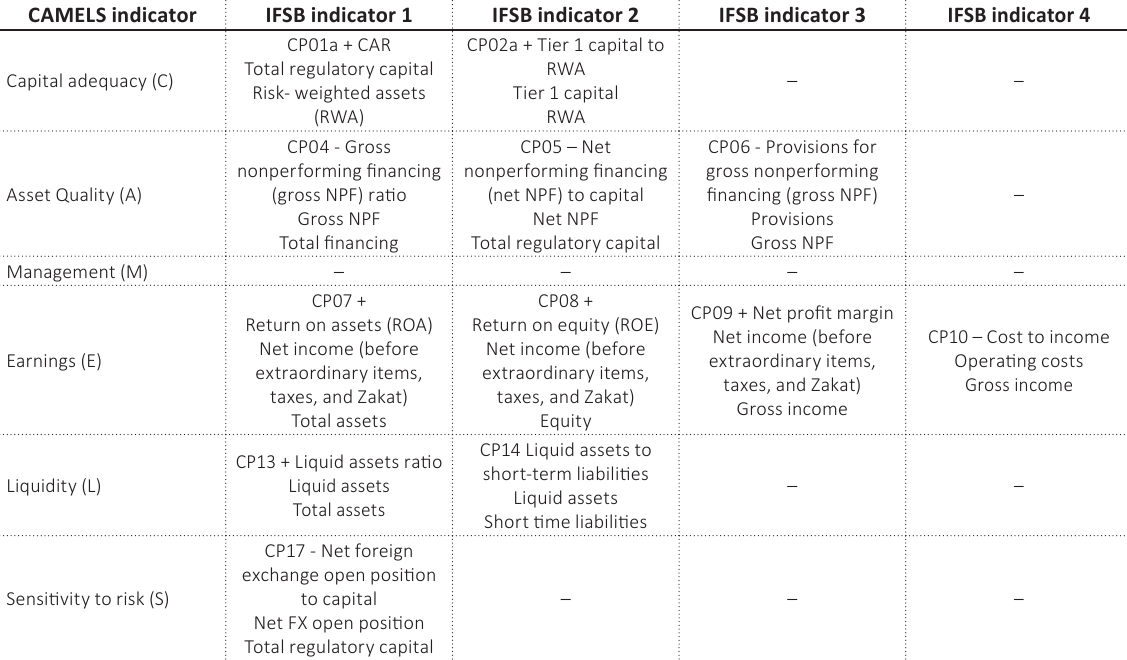
Table 2. Relationship between the CAMELS and IFSB indicators, with denotation of the